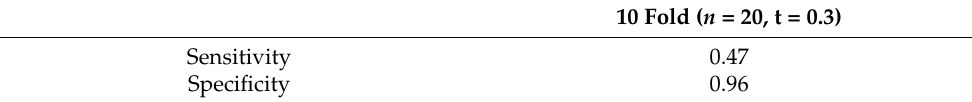
Table 1. Sensitivity and specificity of OSCC diagnosis utilizing the MobileNet